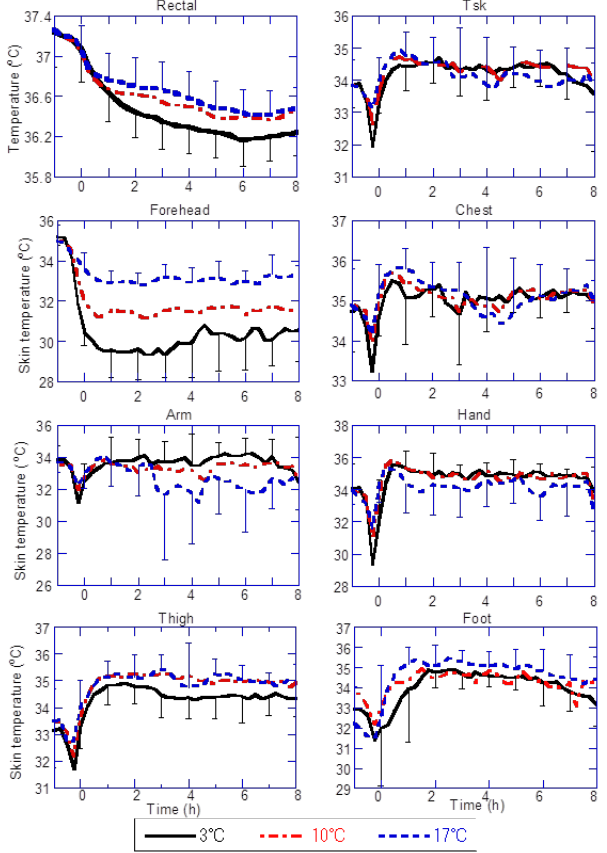
Figure 1. The time course of changes in Tre, mean Ts and local Ts, at seven sites for the three Ta conditions.